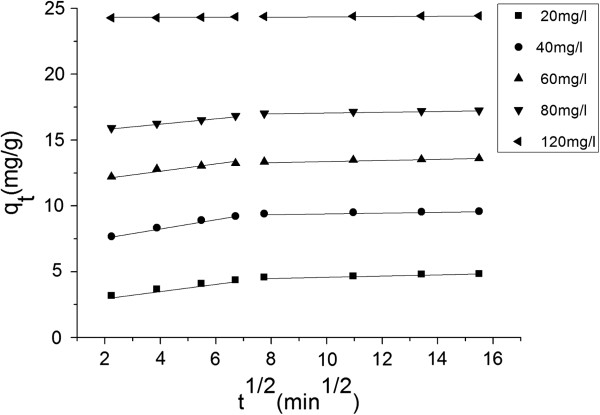
Intraparticle diffusion model for MG biosorption at different initial concentrations.